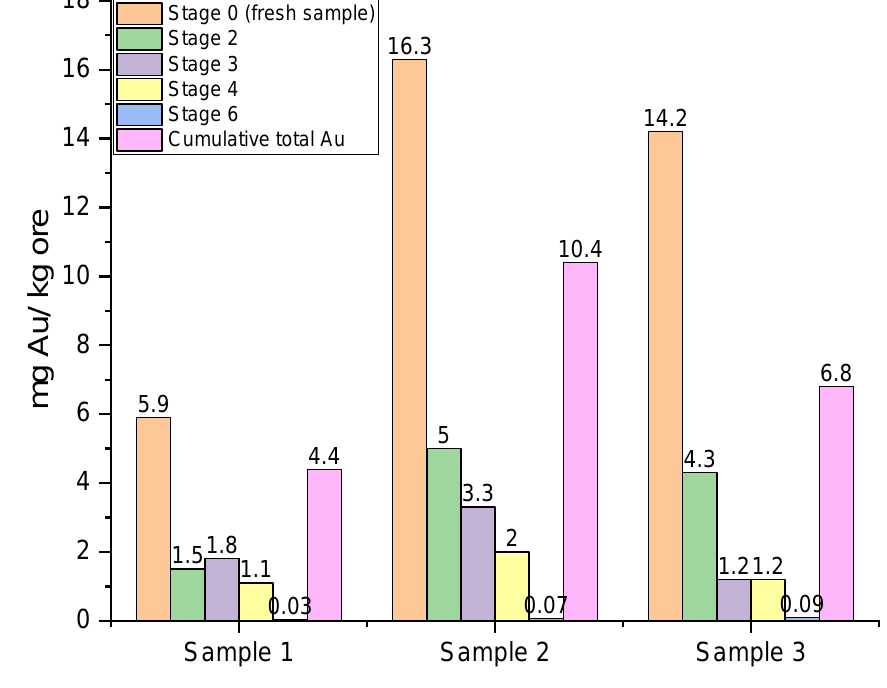
Figure 6. Au extraction in each stage for each